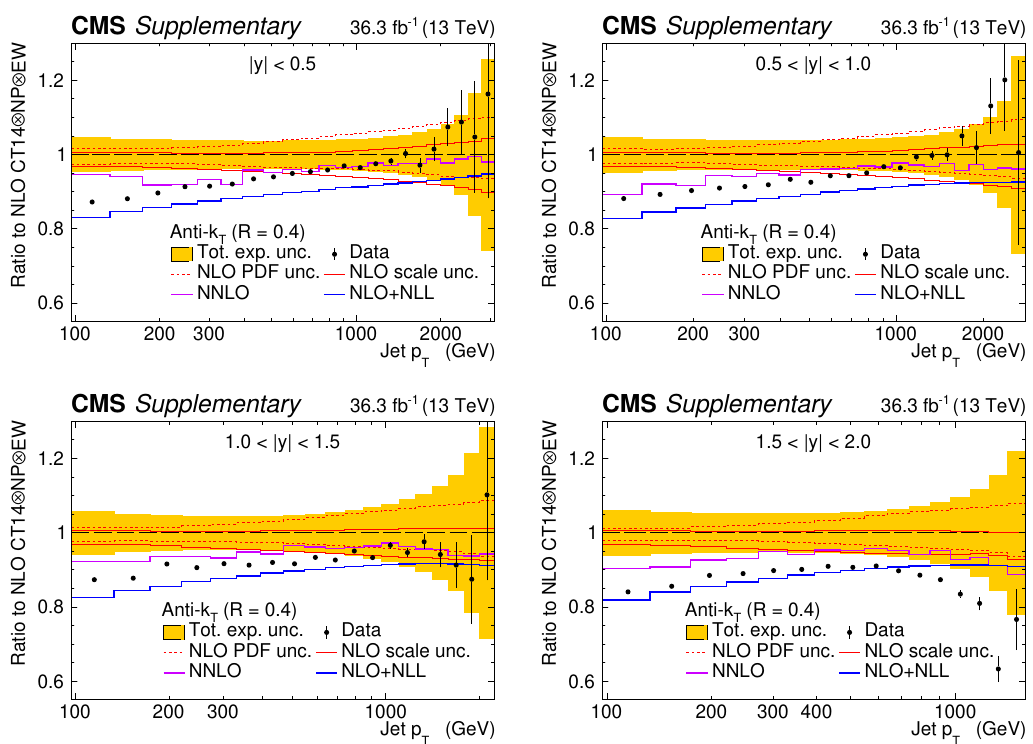
Figure 20 . Cross sections of inclusive jet production for distance parameter R = 0 . 4 as a function of transverse momentum of the individual jet in bins of absolute rapidity | y | , compared to the theoretical predictions at NLO, NLO+NLL, and NNLO. All results are normalised to the prediction at NLO. The measurement (solid symbols) is presented with the statistical uncertainties (vertical error bars), while the systematic uncertainty is represented by a yellow filled band, centered at 1. The NLO (black dashed line) and NLO+NLL (blue solid line) predictions are obtained using CT14nlo PDF. The PDF (dotted red line) and scale (solid red line) uncertainties are shown for the NLO prediction. The NNLO calculation (purple solid line) is obtained using CT14nnlo